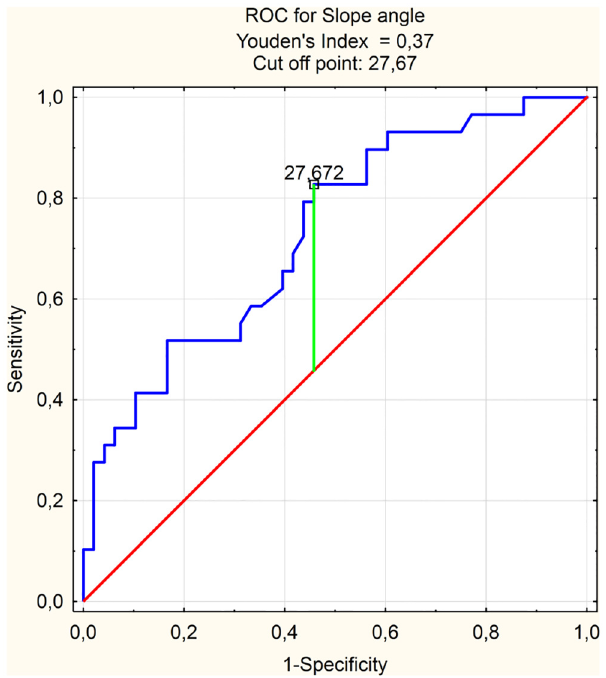
Fig 4. ROC and cut off point for Slope angle. ROC — receiver operating characteristic.